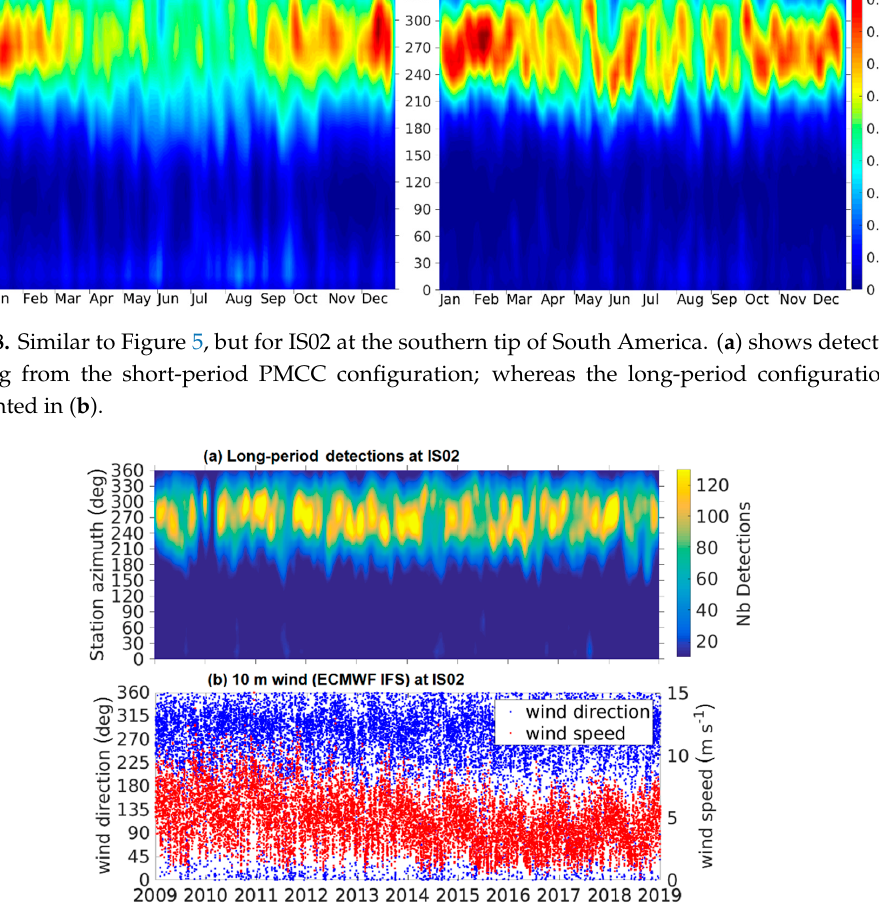
Figure 9. Similar to Figure 6, but for IS02 in south Argentina. The PMCC back-azimuth standard deviation of the detected events included in ( a ) is, on average, 0.5 ◦ . The correlation coe ffi cients, as determined by the PMCC algorithm, average to 0.73 ± 0.1. ( b ) At IS02, the average wind speeds are higher than at tropical